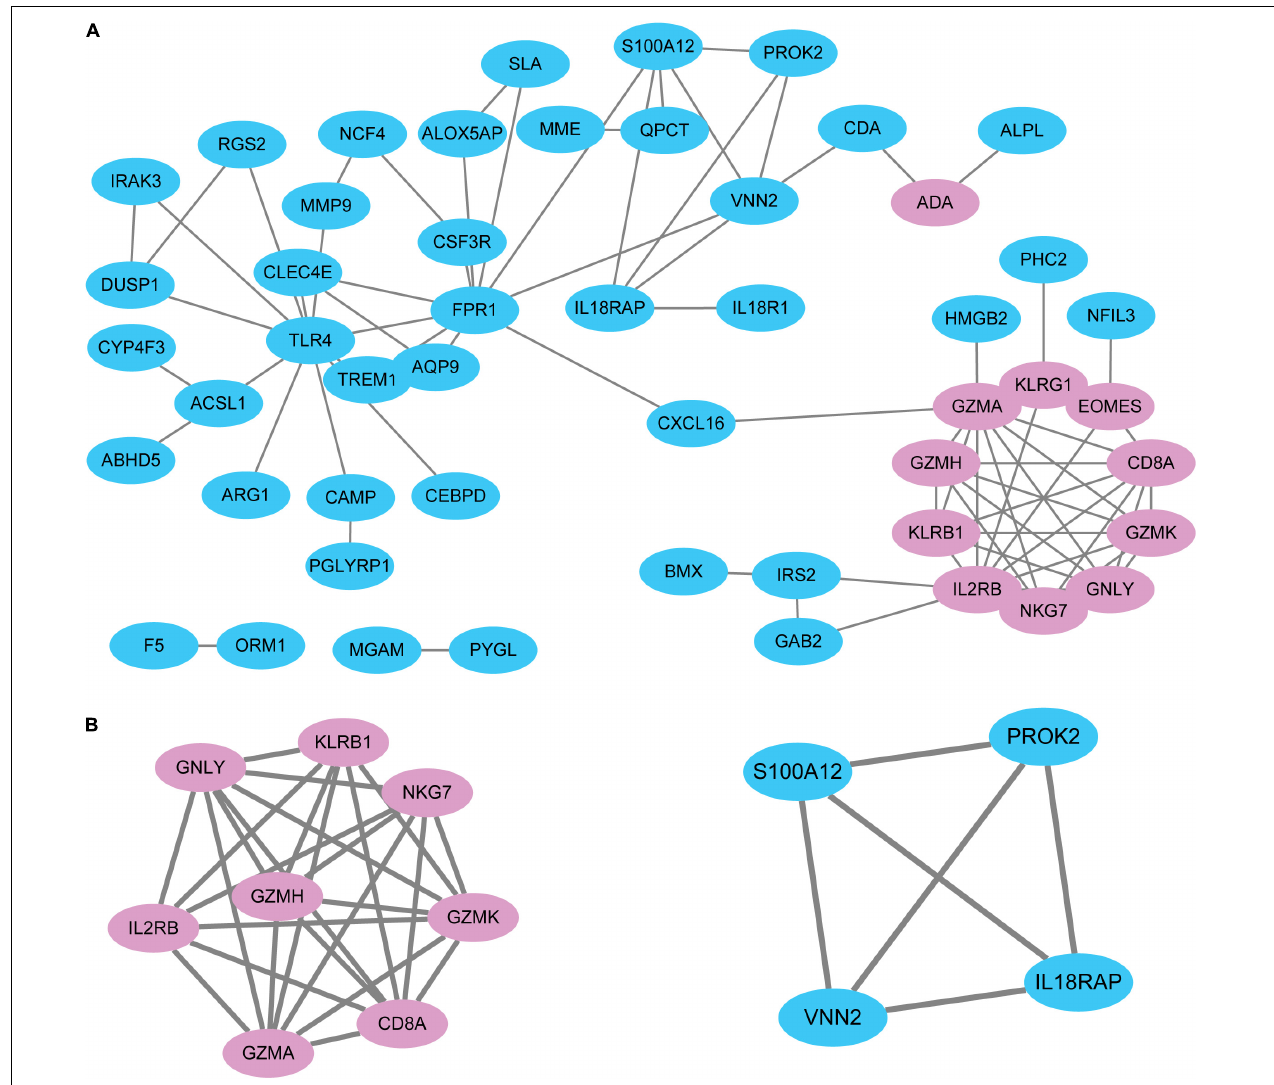
FIGURE 3 | The PPI network of DEGs identified in STEMI. (A) A network panorama composed of all the DEGs. Blue nodes indicate upregulated genes, while pink nodes indicate downregulated genes. The lines between nodes represent the interactions between genes. (B) Two key modules were identified based on MCODE (molecular complex detection) analysis. Left: Cluster 1. Right: Cluster 2. The biological process analysis of hubgenes from Cluster 1 ( Supplementary Figure 1 ) and Cluster 2 ( Supplementary Figure 2 ) was constructed using BiNGO.